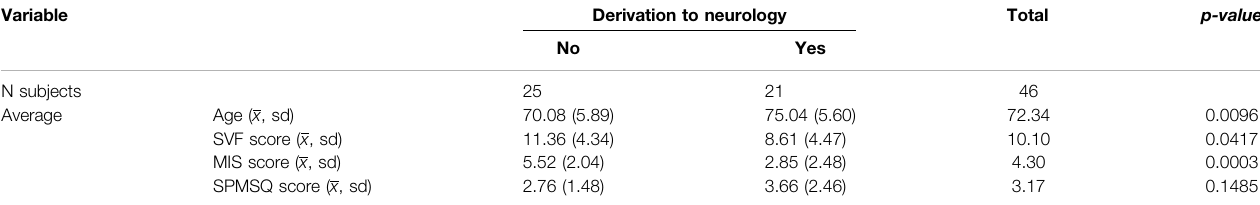
TABLE 5 | Statistical differences regarding referral to neurology in IPC (interprofessional collaboration) group. Variable